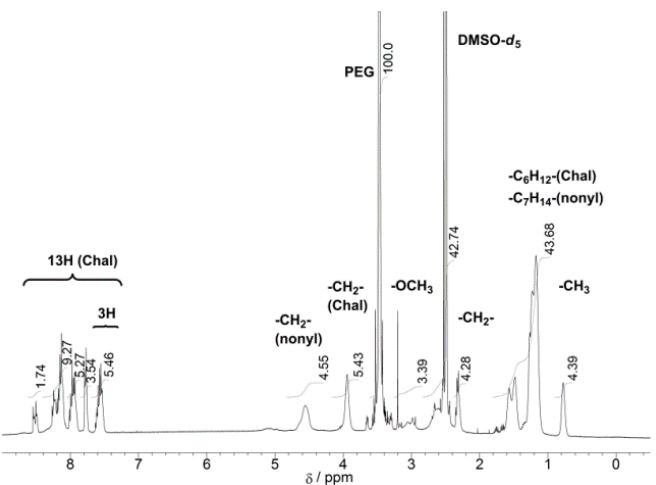
Figure 1. 1 H NMR spectrum of the PEG-P(Asp-nonyl-chal-C 8 ) block copolymer in DMSO- d 6 containing 3 v / v % TFA. Table 2. Results of the conjugation of chal-C x and C y H 2 y +1 to PEG-P(Asp(26)).